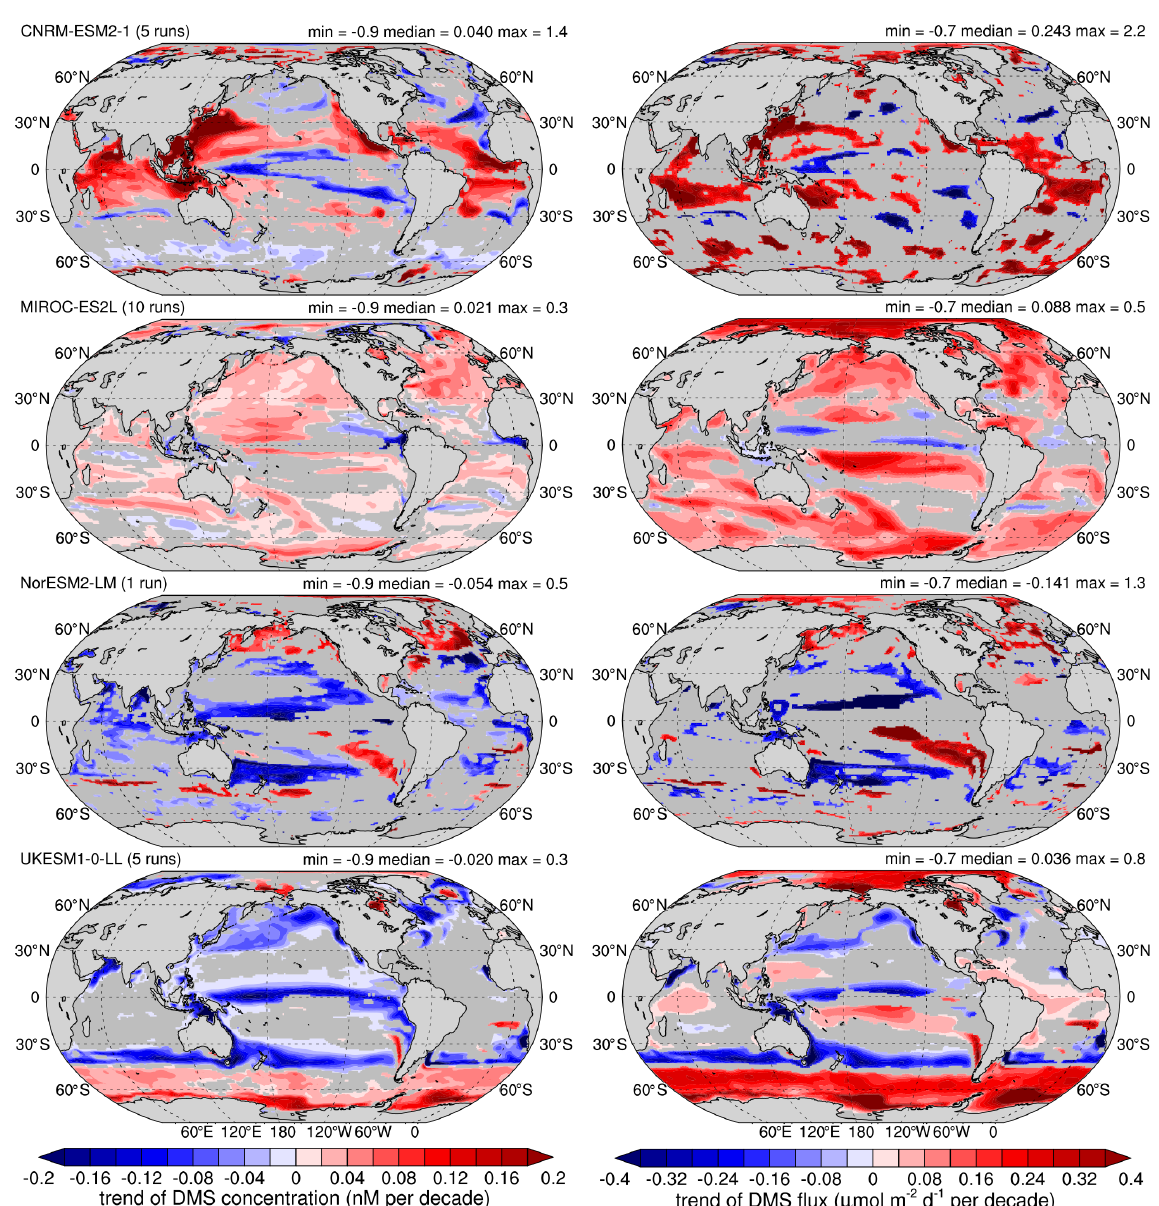
Figure 12. Same as Fig. 11 with trends computed here over 2071–2100 from the ssp585 simulations. Note the scales are identical to Fig.